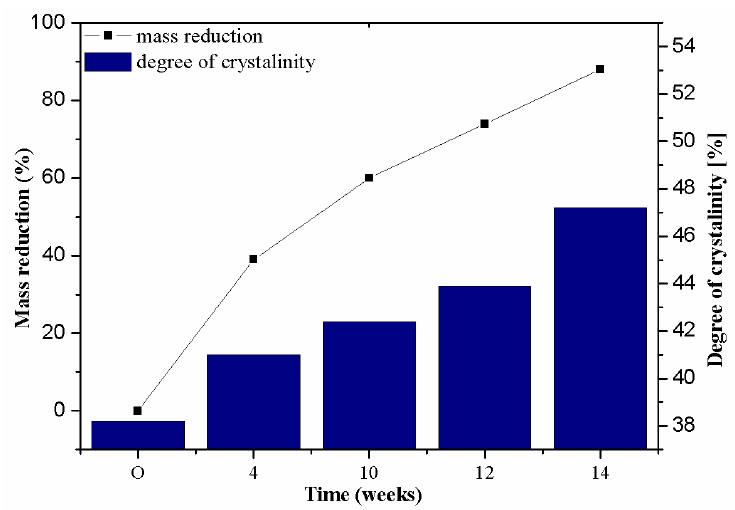
Figure 7. Dependence of the material mass loss over time on the degree of crystallinity.